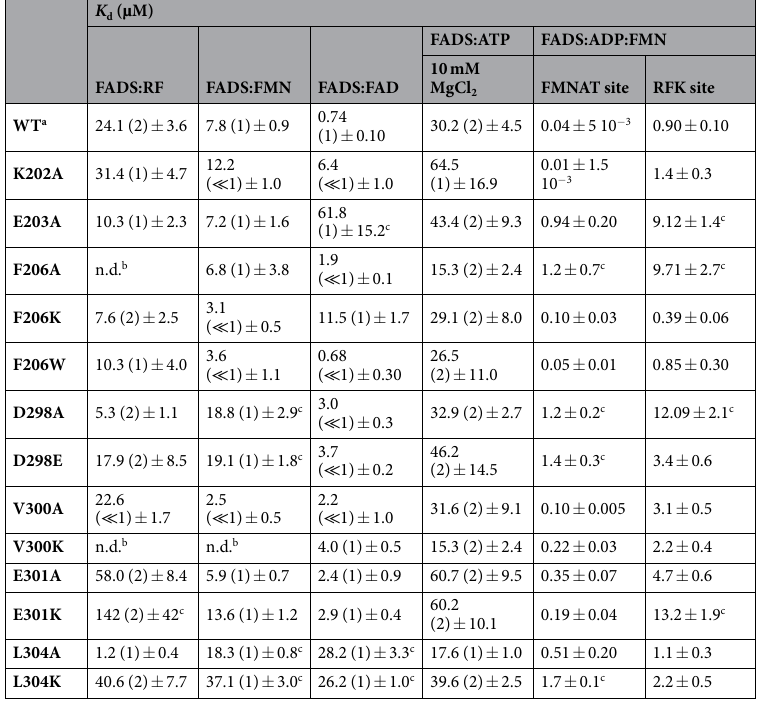
Table 3. Binding parameters for the interaction of WT and mutated Ca FADSs with RF, FMN, FAD and ATP, as determined by ITC (n = 3; means ± SD). The stoichiometry for the interaction is shown in brackets. For those showing a stoichiometry of N = 2, data correspond to an average K d ( K d,av ) of two independent binding sites. Data obtained at 25 °C in 20 mM PIPES pH 7.0, 10 mM MgCl 2 . a Data from 16, 21 . b Despite these variants exhibiting different spectra upon mixing with the ligand, no heat exchange was detected in the corresponding ITC titration, indicating a very low binding enthalpy. c Values showing statistically significant differences from the WT, as determined by the one-way ANOVA test ( P < 0.002; n = 3, confidence interval